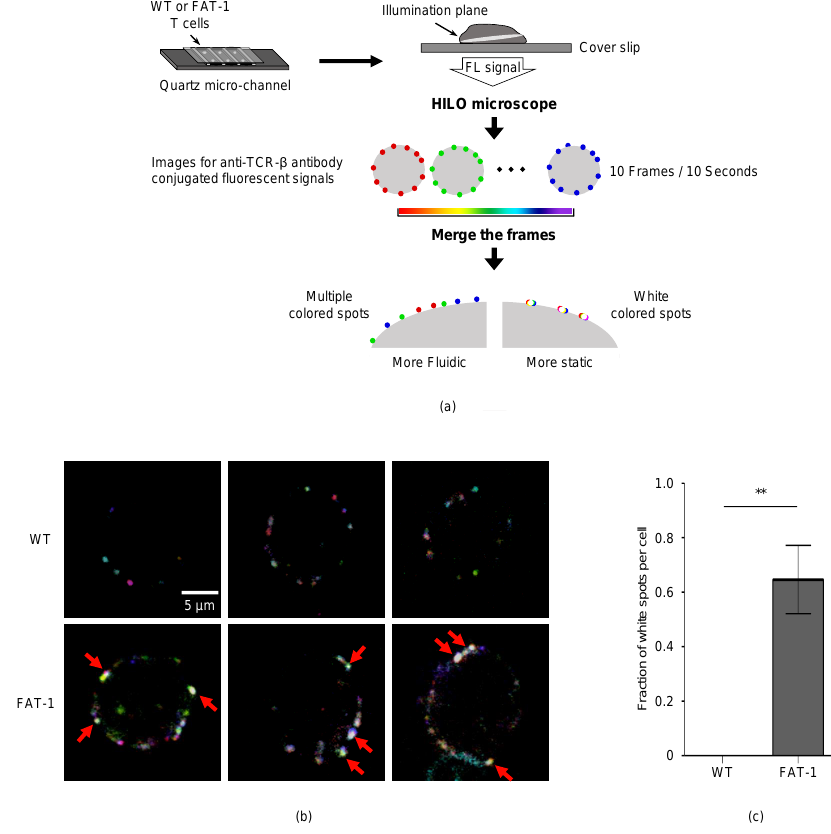
Figure 3. The endogenous n -3 PUFA decreases T cell receptor (TCR) mobility on CD8 + T cells. ( a ) An experimental scheme is shown. The WT or FAT-1 CD8 + T cells were stained with an anti-mouse TCR- β -PE antibody and loaded into a quartz micro-channel, followed by analysis using a highly inclined and laminated optical sheet (HILO) microscope. ( b ) Three representative merged images for the TCRs on the WT or FAT-1 CD8 + T cells are shown. The red arrow indicates the white spot. ( c ) The fraction of less mobile spots that appear as white spots in the merged image over 10 frames was calculated by counting the number of white spots and dividing it by the average number of total spots per frame. **, p <